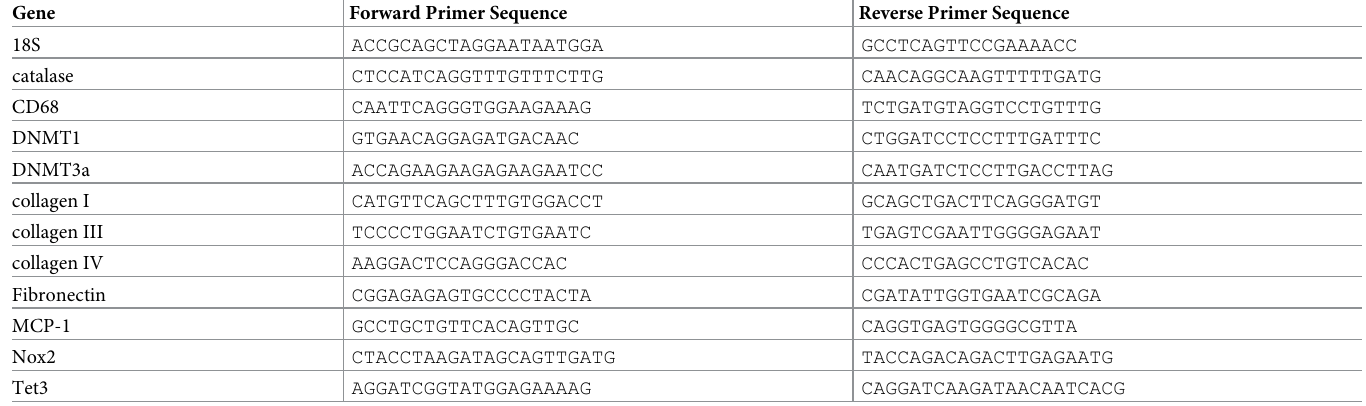
Table 1. Mouse specific primers used in quantitative real-time PCR.